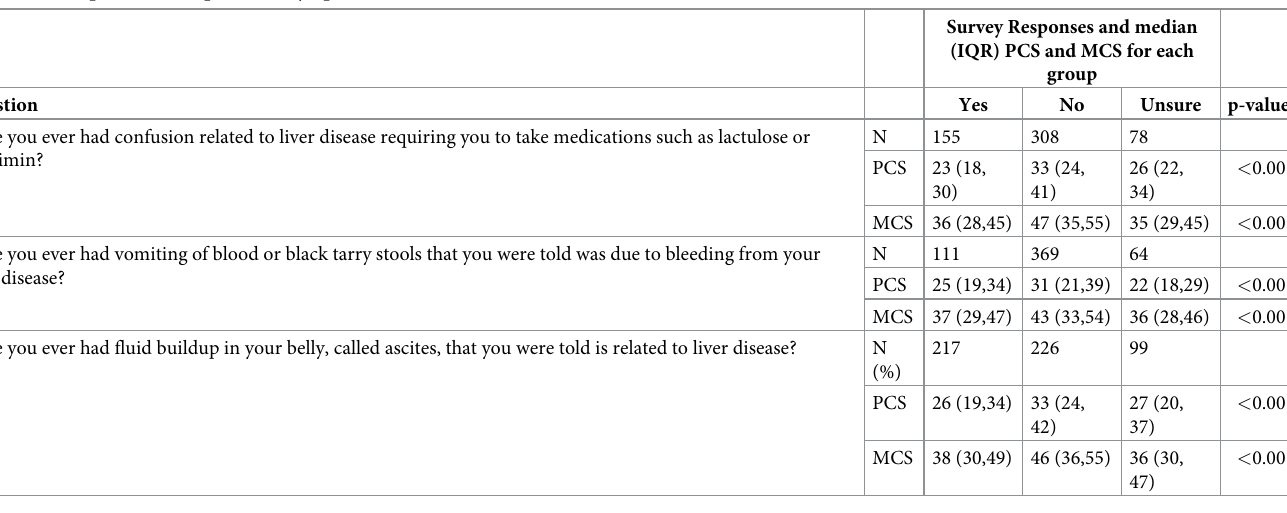
Survey Responses and median (IQR) PCS and MCS for each